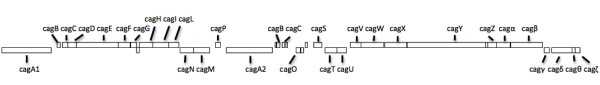
Diagram of the cag PaI from the Peru strain. Indicated in the figure is the position of the duplicated cagA gene.